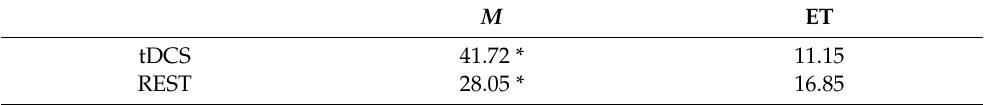
Table 7. Mood scores during the tDCS phases compared to the rest